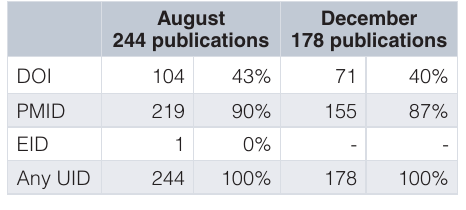
Table 5a. Publication type in Pure of publications with UID exported from Pure to SciVal and matched. Download